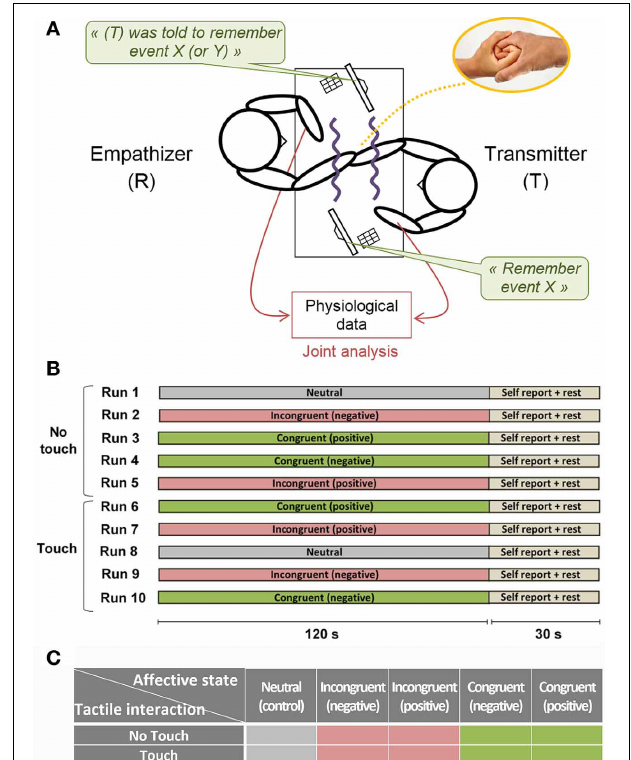
FIGURE 1 | Experimental setup. (A) Schematic view of the experimental apparatus. Visual contact between subjects was completely prevented using two opaque partitions. Screens and input devices allowed giving unique instructions to each subject and collecting subjective feedbacks throughout the experiment (B) Experimental design. During the five first runs any information exchange is prevented between subjects. During the five last runs, partners can freely touch each other’s hand and forearm in a concealed space between opaque partitions. Within Touch or No Touch blocks the run order is randomized. At the end of each run participants reported subjective feedbacks about emotion intensity and perceived coupling with their partner. (C) Factorial